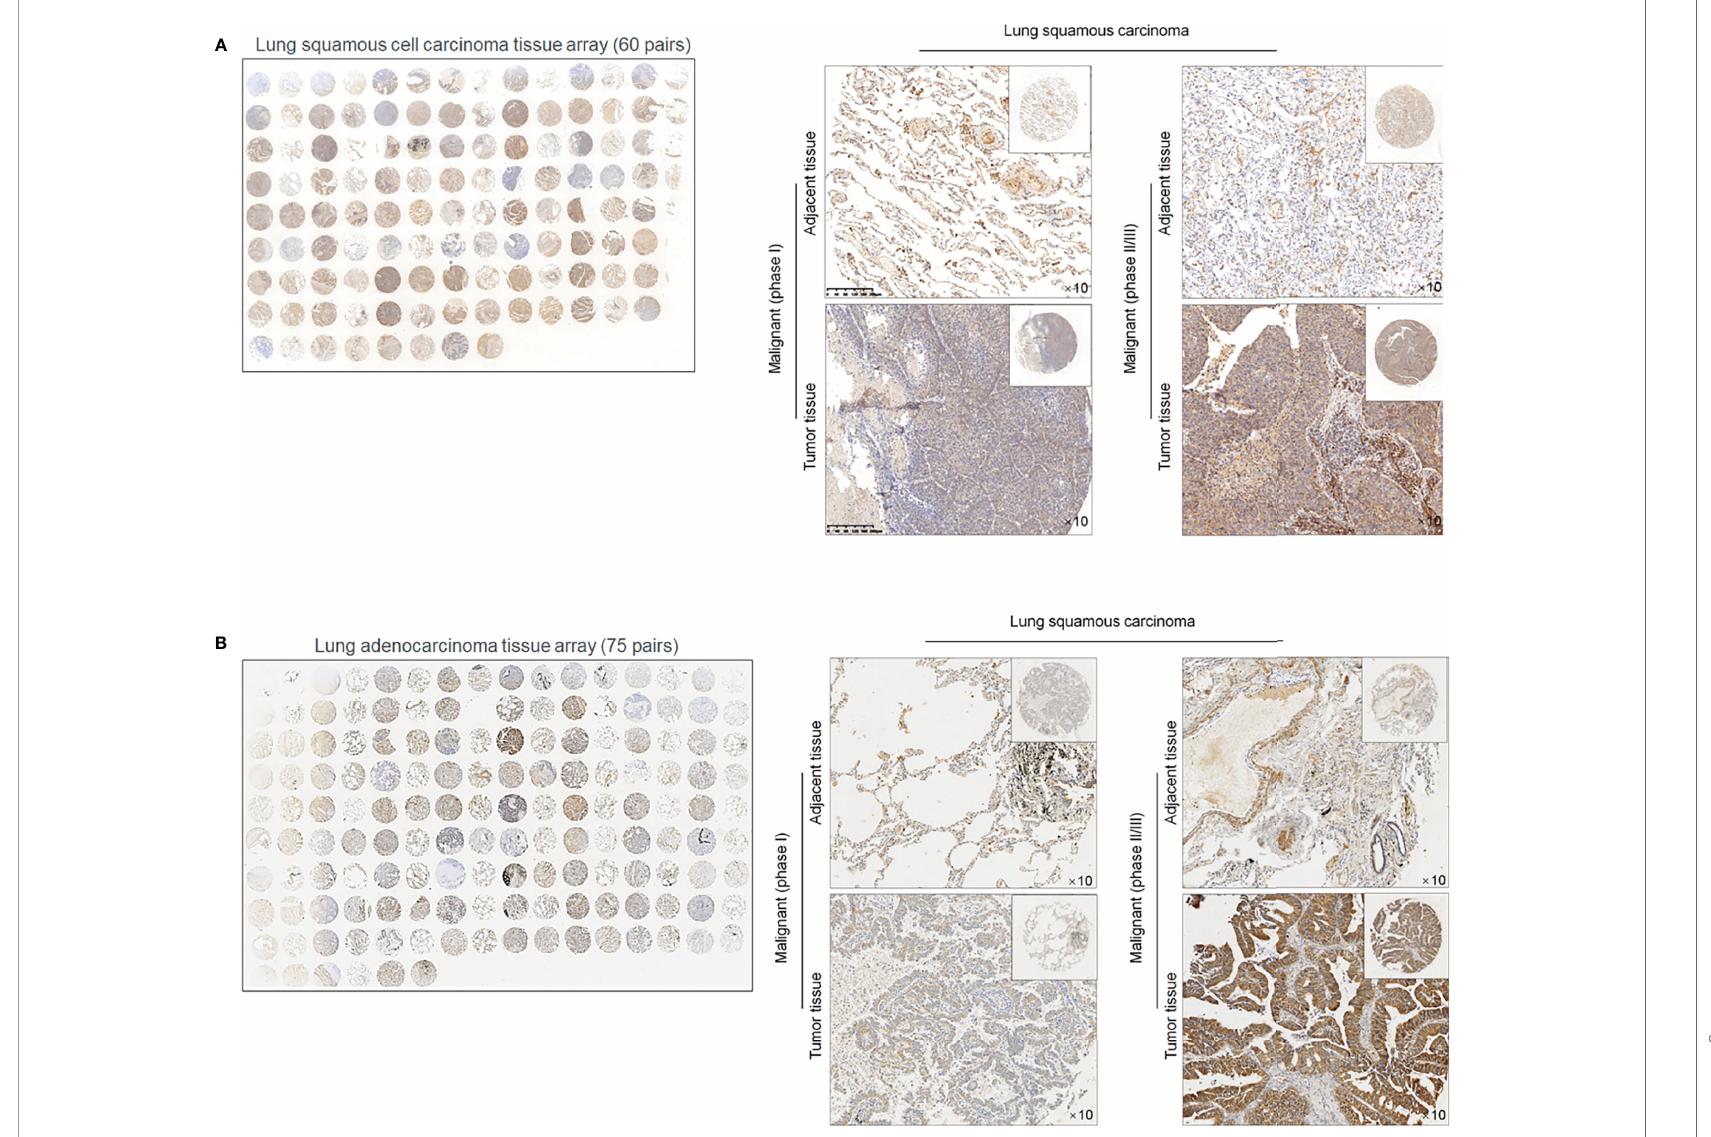
FIGURE 4 | ALKBH5 protein is expressed relatively higher in lung cancer tissues compared to adjacent non-tumor tissues60 paired lung squamous cell carcinoma (LUAD) tissue array (A) and 75 paried lung adenocarcinoma (LUSC) tissue array was employed for ISH staining of ALKBH5 (B)